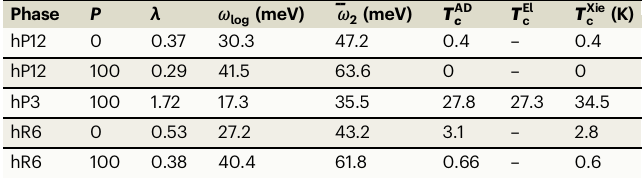
Table 1 | Pressure (P in GPa), the ω spectral function α 2 F ( ω ) in units of meV and the predicted Allen – Dynes equation 47 , isotropic Eliashberg, and